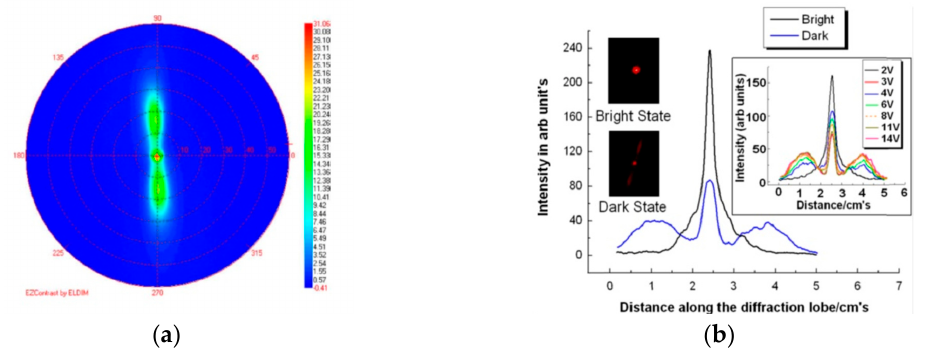
Figure 21. ( a ) The luminance viewing angle plot for the FLC in the dark state, ( b ) the intensity profile